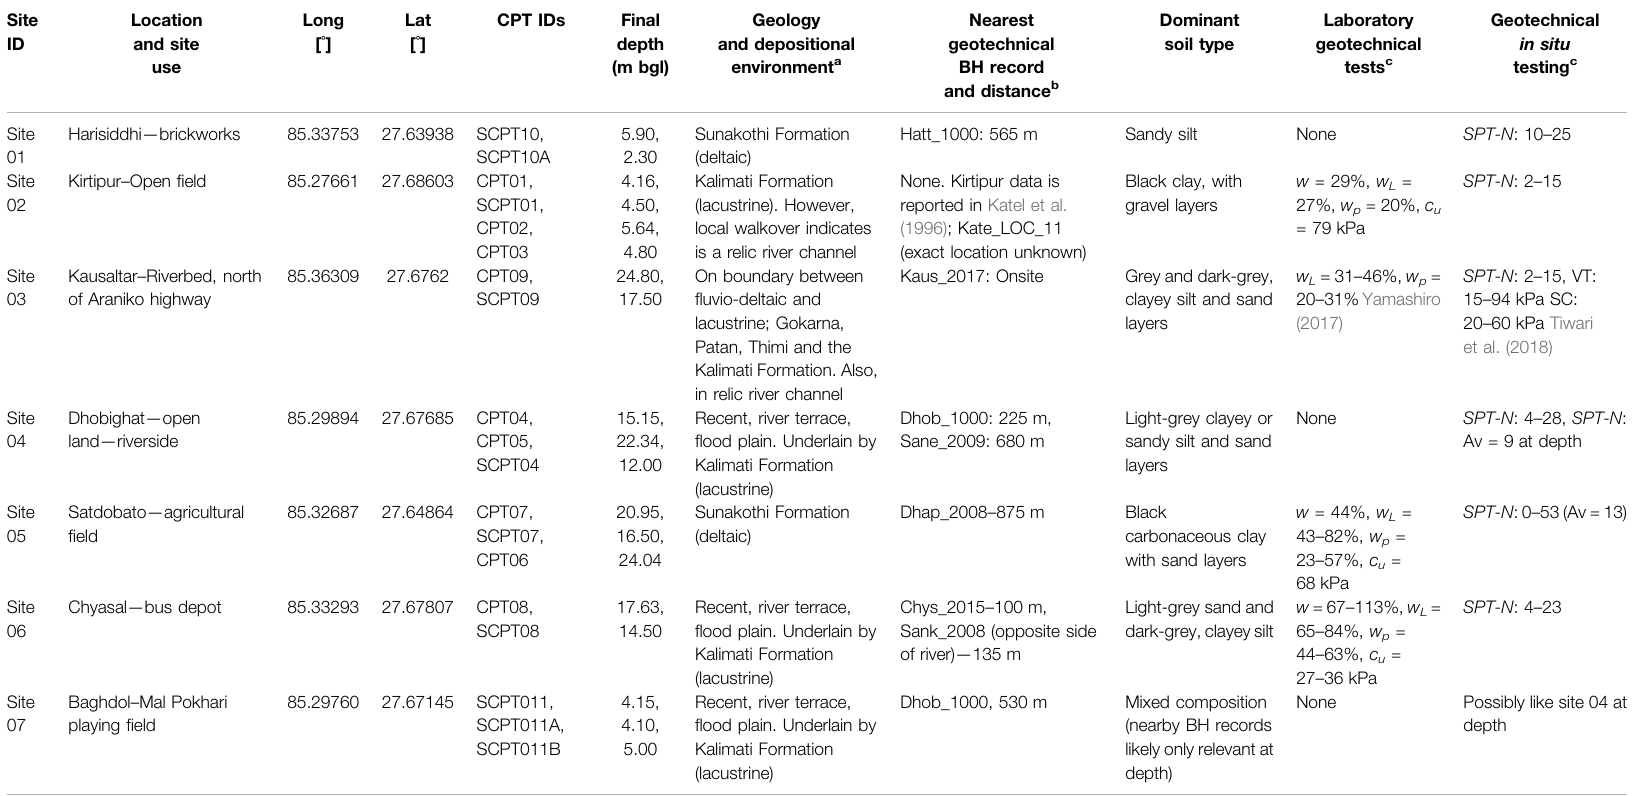
TABLE 1 | Locations of CPT ground investigations, geology and closest borehole